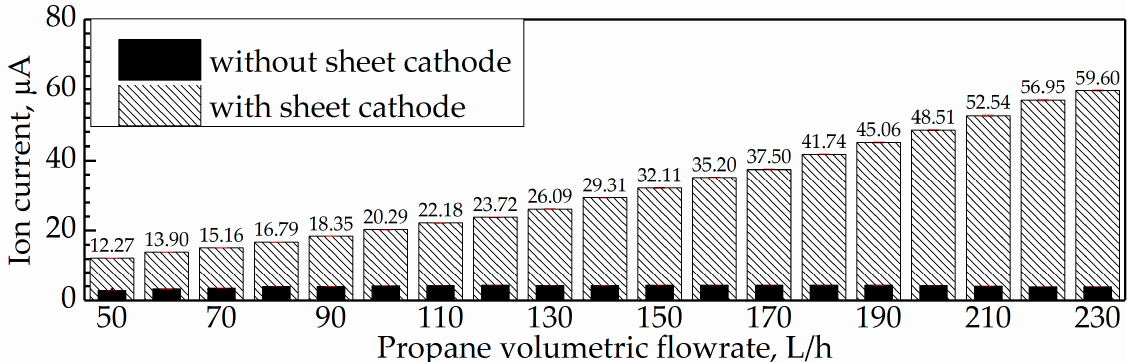
Figure 21. Schematic of the electrode structure for experiments of Factor 1. Table 7. Comparison of the average ion current from the original and improved sensor.